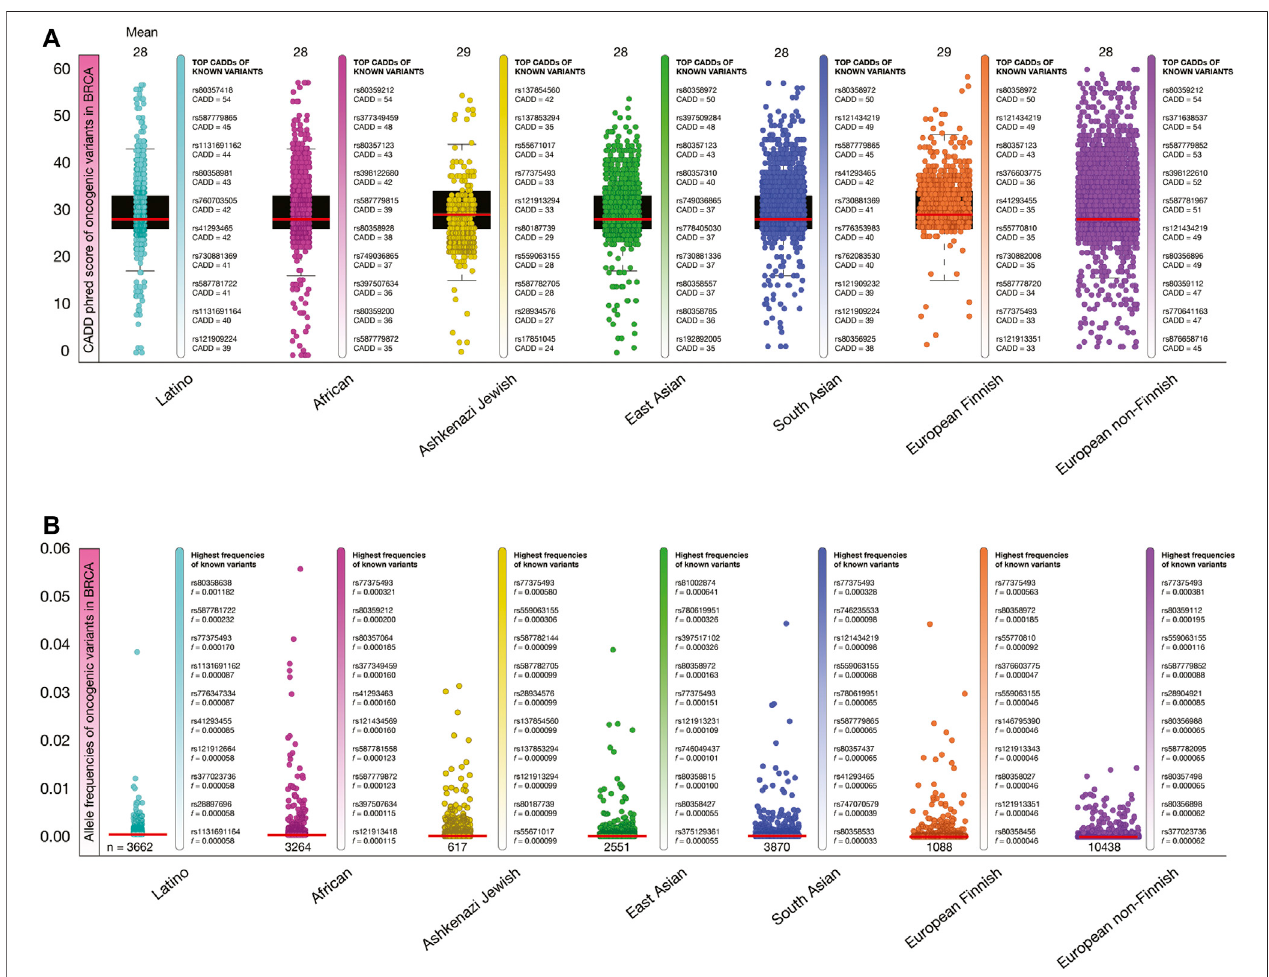
FIGURE 5 | Deleteriousness scores and allele frequencies of BRCA oncogenic variants per human population. (A) Box plots show CADD phred scores of BRCA known and predicted oncogenic variants per human population. Vertical bars show ranking of known oncogenic variants with the highest CADD phred scores per human population. Red lines show the mean of deleteriousness scores per human population. (B) Box plots show allele frequencies of known and predicted BRCA oncogenic variants per human population. Vertical bars show ranking of known oncogenic variants with the highest allele frequencies per human population. Red lines show the mean of deleteriousness scores per human population. (C) Ranking of known oncogenic variants with the highest allele frequencies identi fi ed in breast cancer patients from TCGA-BRCA project.